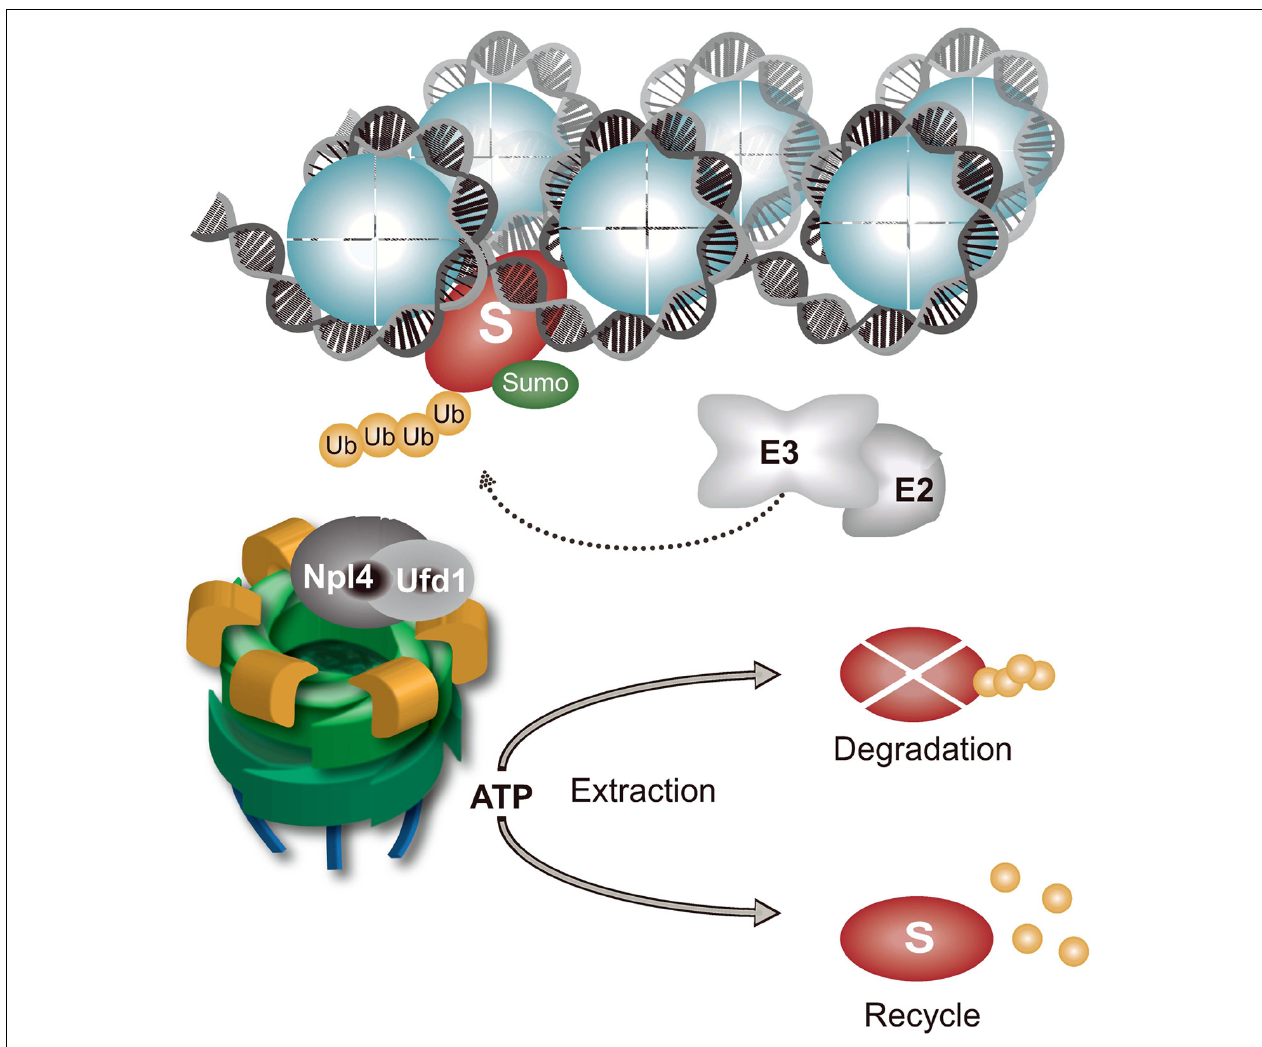
FIGURE 2 | Chromatin-associated protein degradation (CAD) regulated by p97 –Ufd1–Npl4 . Chromatin-bound proteins (S represents any known p97 substrate on chromatin) are polyubiquitinated and sumoylated by specific E3 ubiquitin and SUMO ligases. p97 − Ufd1 − Npl4 complex is recruited to polyubiquitinated substrates by a ubiquitin-binding domain in Npl4 or Ufd1.